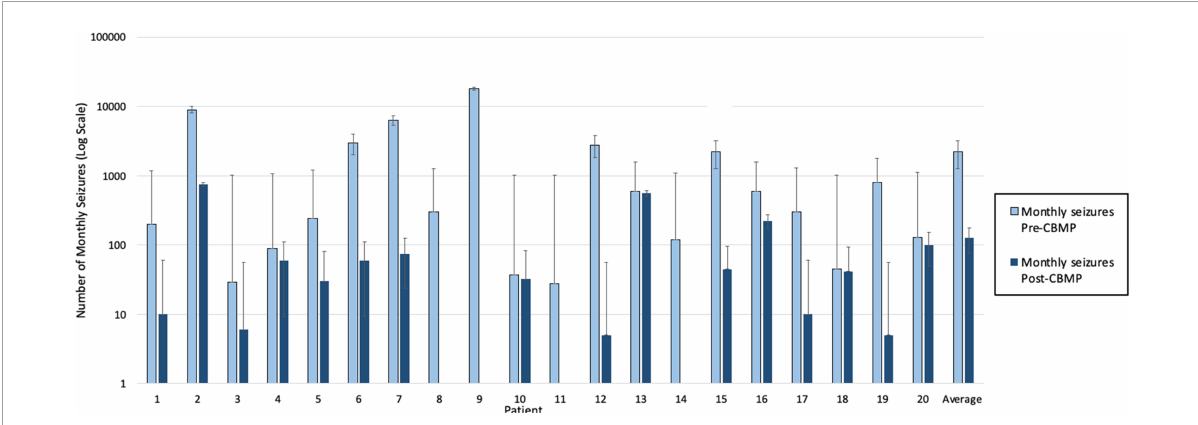
FIGURE1 Monthly seizure frequency pre- and post- cannabis based medicinal products